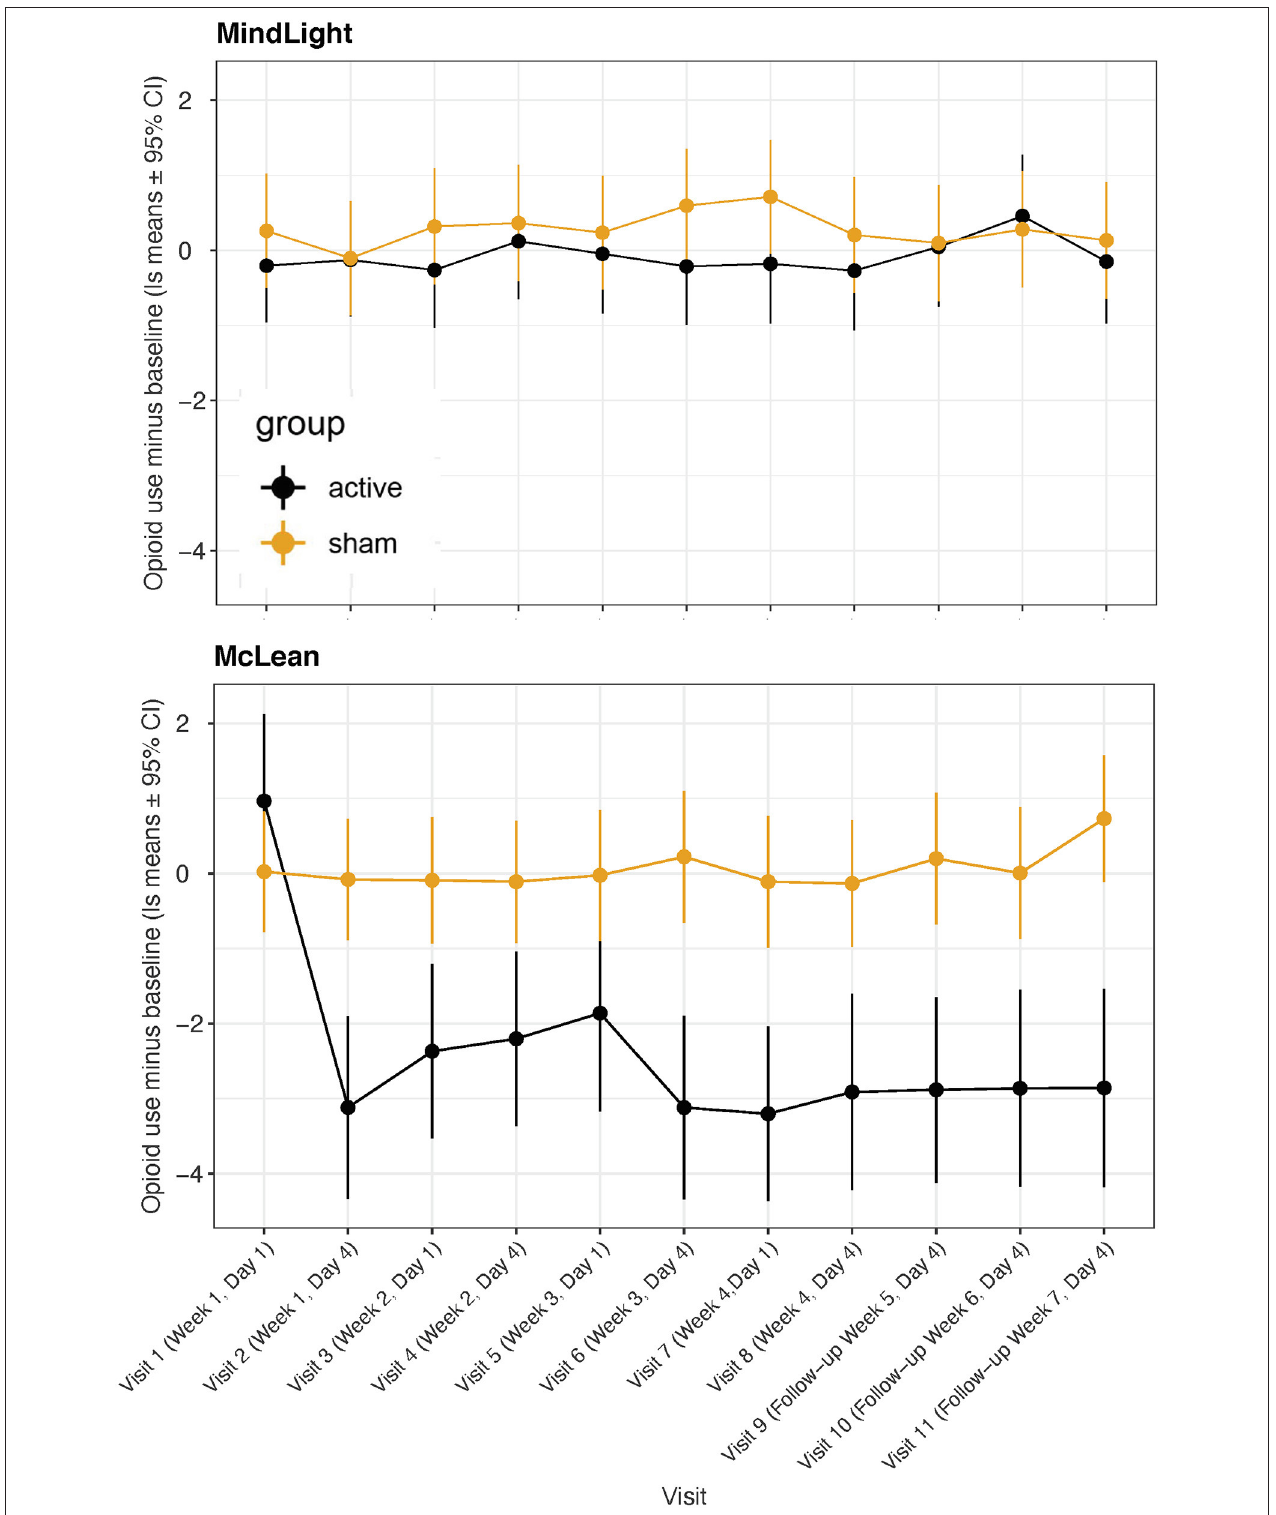
FIGURE 5 | Least square means for Opioid Use (days * amount) minus baseline from TimeLine FollowBack across visits for active vs. sham treatment at MindLight and McLean sites.